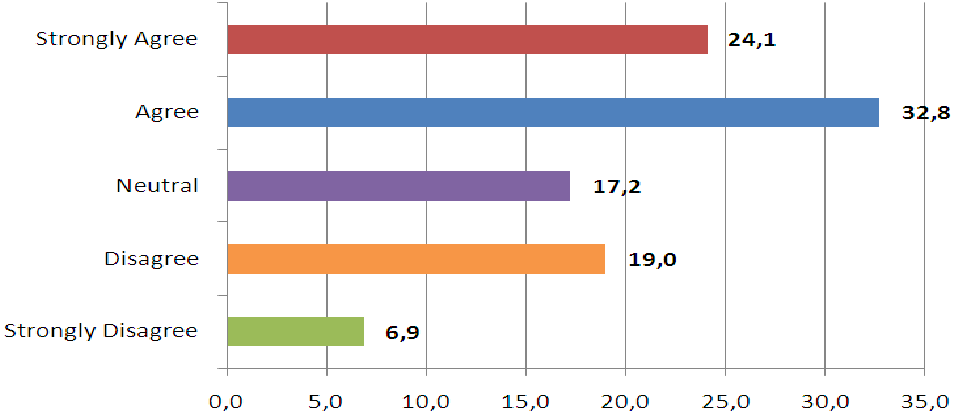
Fig. 4. Always offered the option of Islamic banking to Muslim